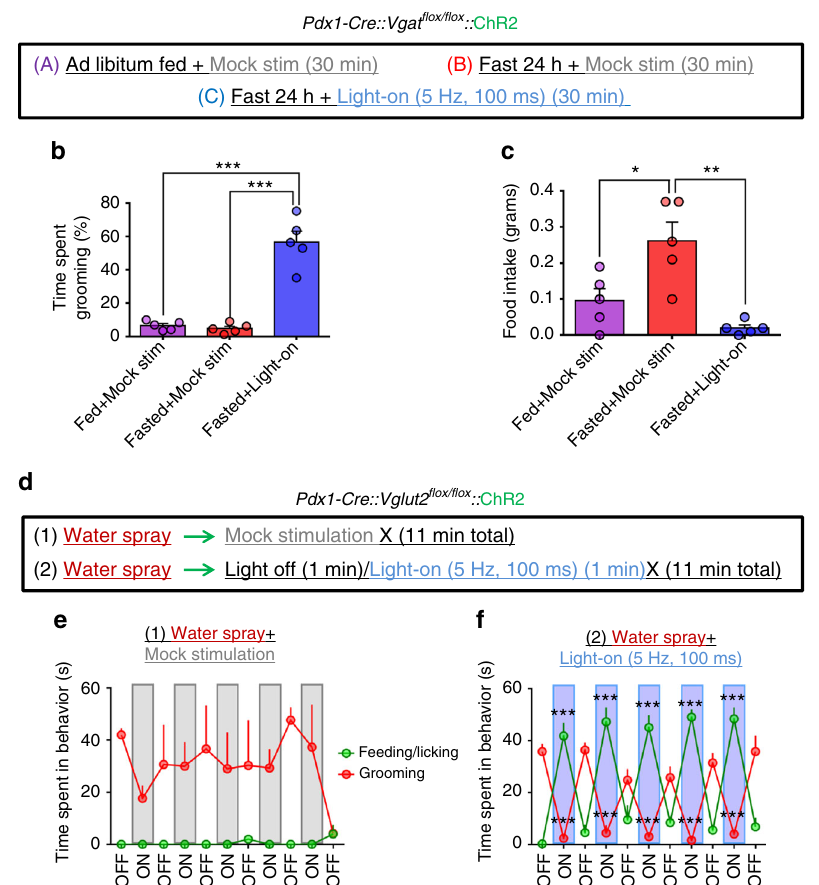
Fig. 6 Antagonistic control of feeding and self-grooming by GABAergic and glutamatergic LHPdx1 → PVH fi bers. a Experimental design for testing effects of glutamatergic LH Pdx1-ChR2 → PVH fi ber photostimulation on grooming and refeeding after a fast. b The percentage of time spent grooming during three 30 min trials. c Food intake during the same three trials. b , c Data are presented as mean ± s.e.m.; n = 5 animals; repeated measures ANOVA followed by Tukey ’ s multiple comparisons. ( b Trial condition F [2, 8] = 55.01, P < 0.0001; subjects F [4, 8] = 0.9764, P = 0.4714. Fasted+light vs. Fed+Mock stim and Fasted + Mock stim *** p < 0.0005. c Trial condition F [2, 8] = 12.37, P = 0.0036; subjects F [4, 8] = 1.062, P = 0.4344. Fed + Mock stim vs. Fasted + Mock stim * p < 0.05; Fasted + Mock stim vs. Fasted + light ** p < 0.005.) d Experimental protocol to test whether photostimulation of GABAergic LH Pdx1-ChR2 → PVH fi bers interferes with grooming induced by water spray. e Time spent engaged in grooming or feeding/licking behaviors during mock stimulation ( n = 3). f Time spent grooming or feeding/licking during light-on condition, where 5 Hz, 100 ms light pulses were applied every other minute ( n = 5). e , f Data are presented as mean ± s.e.m.; two-way repeated measures ANOVA followed by Dunnett ’ s multiple comparisons test. ( e interaction F [10, 40] = 1.1, P = 0.3854; light F [10, 40] = 0.8106, P = 0.6199; behavior F [1, 4] = 231.6, P = 0.0001; subjects (matching) F [4, 40] = 0.2938, P = 0.8803. Grooming [ fi